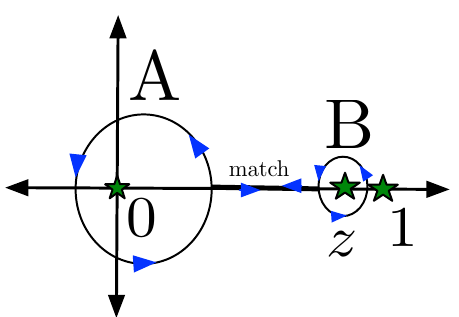
Figure 7 . To compute the monodromy in the desired limit z generic values of y and (B) the region where monodromy matrix by matching the two solutions in an intermediate